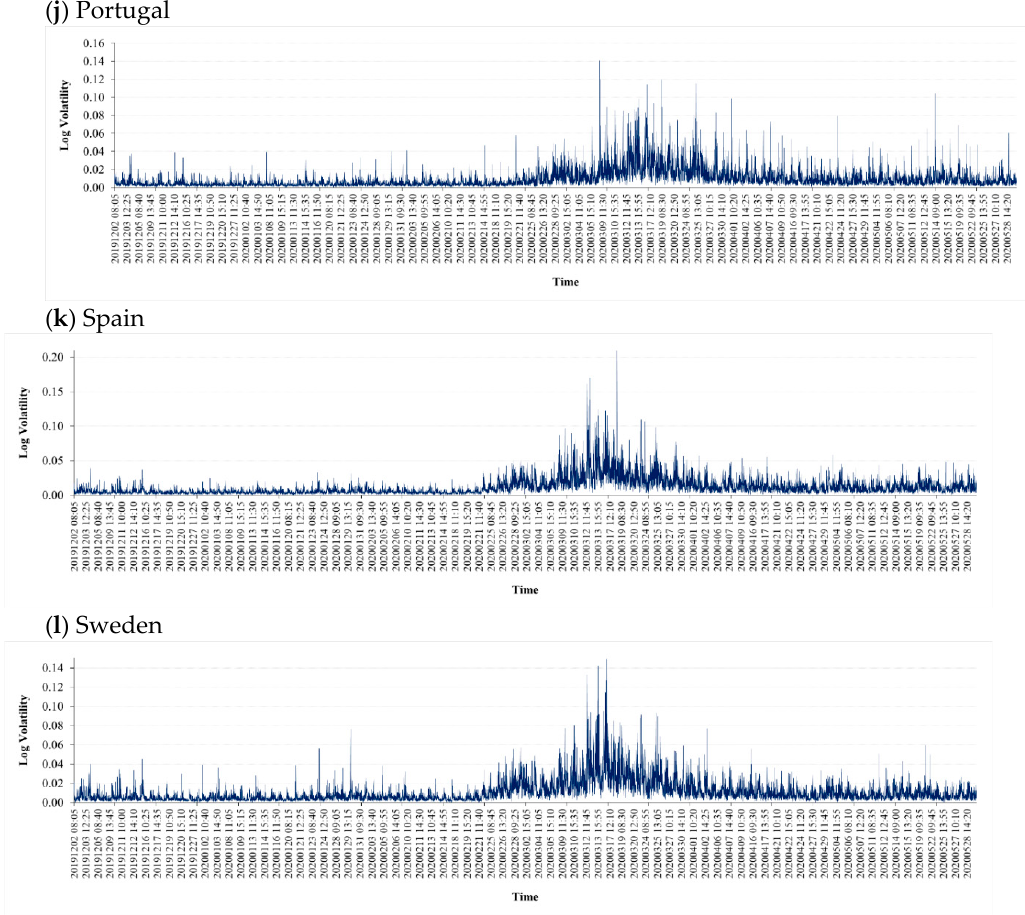
Figure A1. Intraday Volatility of European Stock Markets during COVID-19.